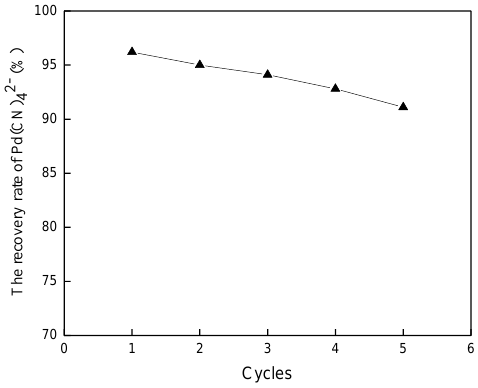
Figure 10. The recovery rates for Pd(CN) 42 − in the mixed solution for five cycles.